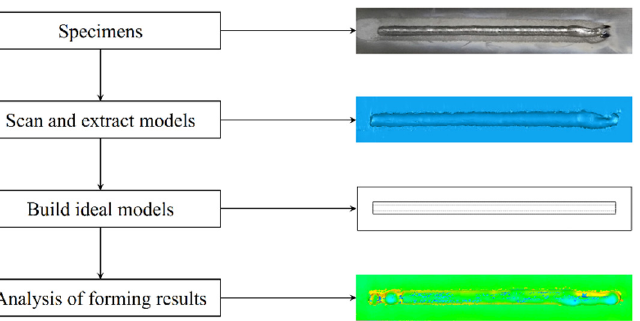
Figure 2. Surface evaluation procedure of the specimen manufactured by WAAM.